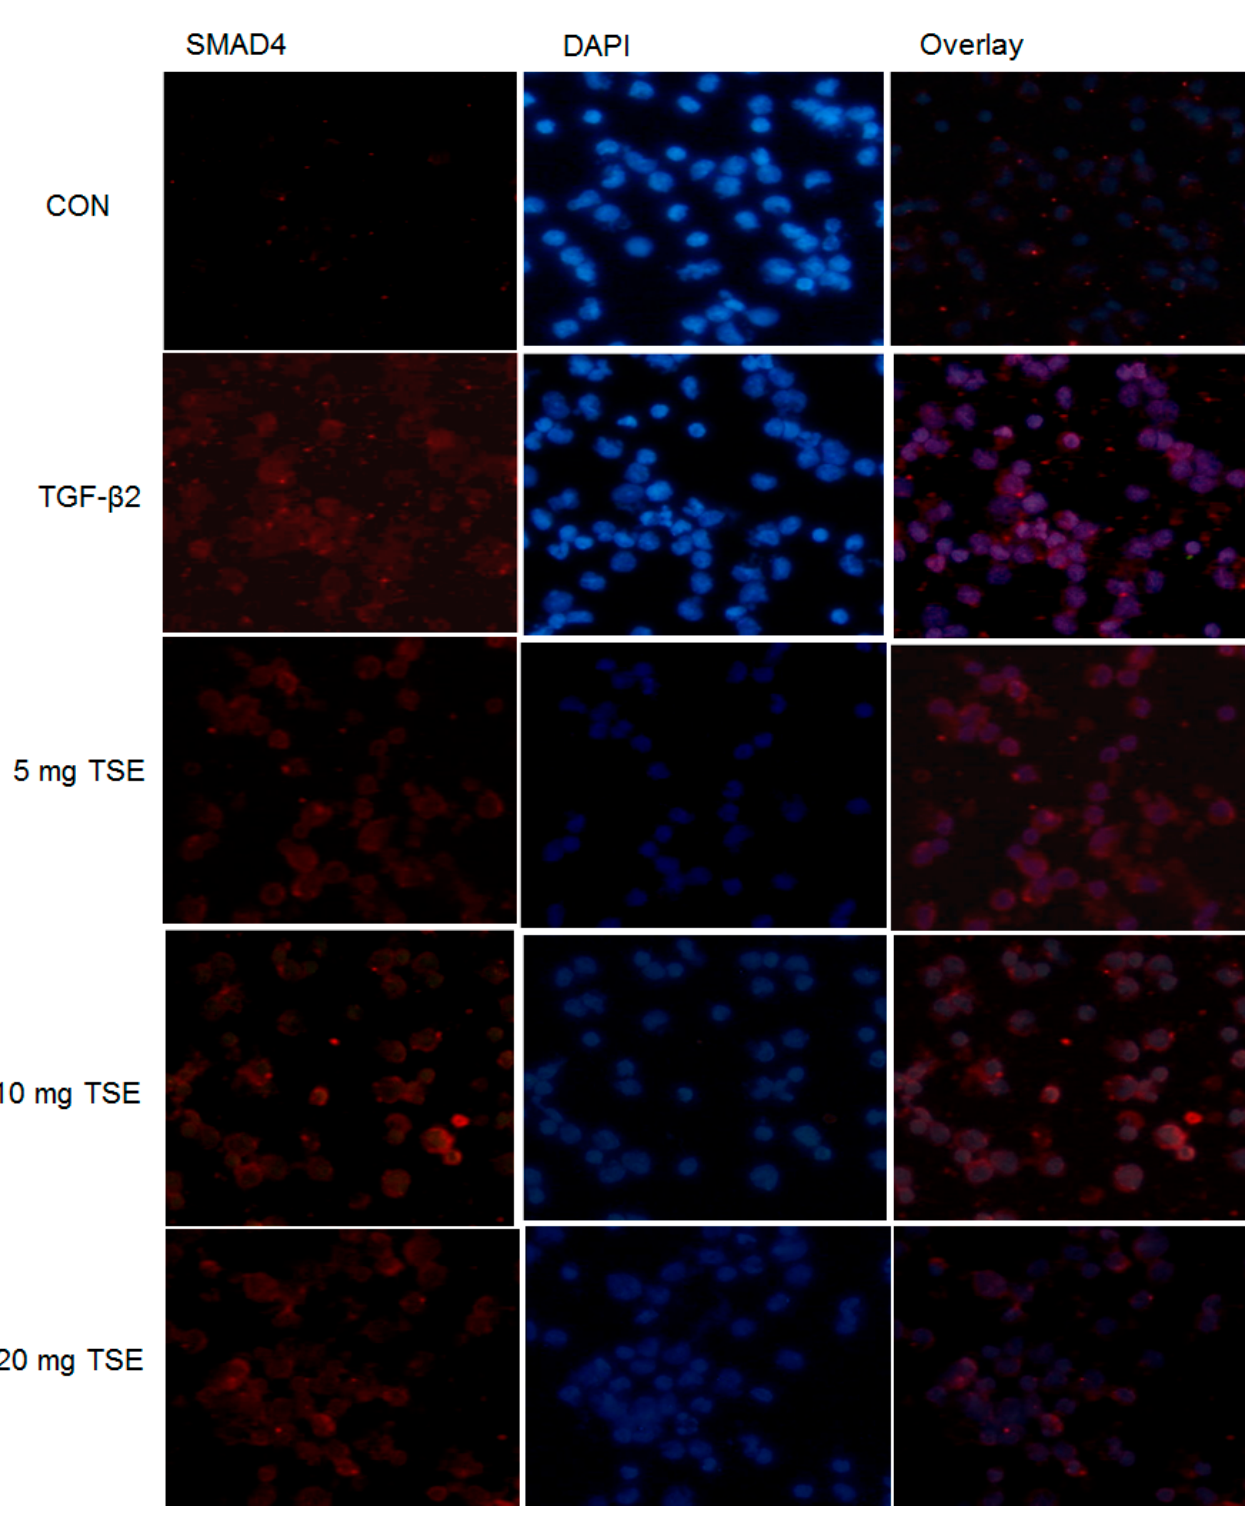
Figure 5. Effects of TSE on epithelial – mesenchymal translocation of SMAD4 using confocal microscopy. The mesenchymal phenotypic marker SMAD4 (red). The nuclei were stained with DAPI (blue). Magnification, ×200.